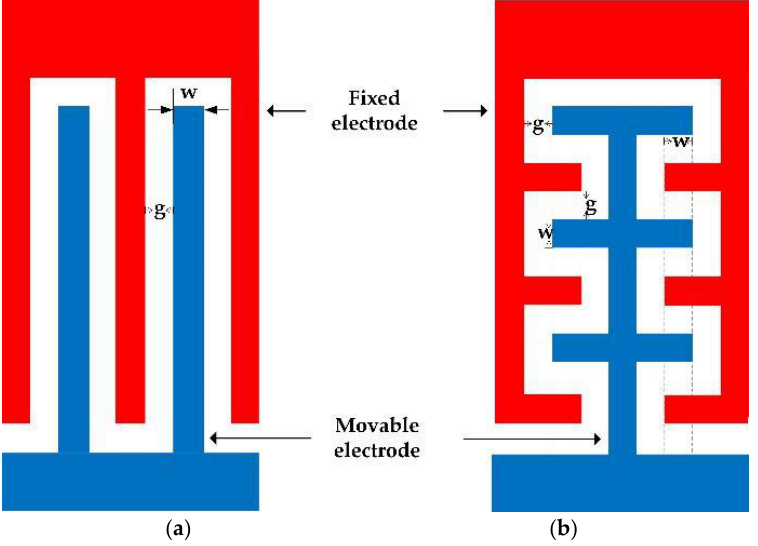
Figure 3. Electrode s setting. ( a ) Interdigital structure. ( b ) Comb-shaped structure.